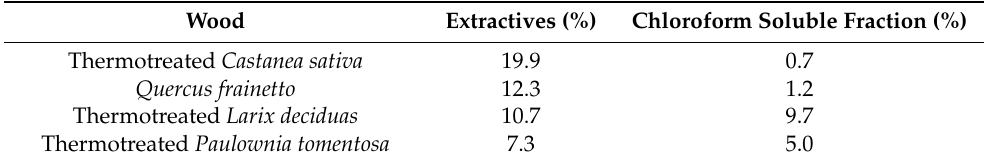
Table 4. Extractives contents in wood samples after water extraction in the presence of H 3 PMo 12 O 40 . Wood